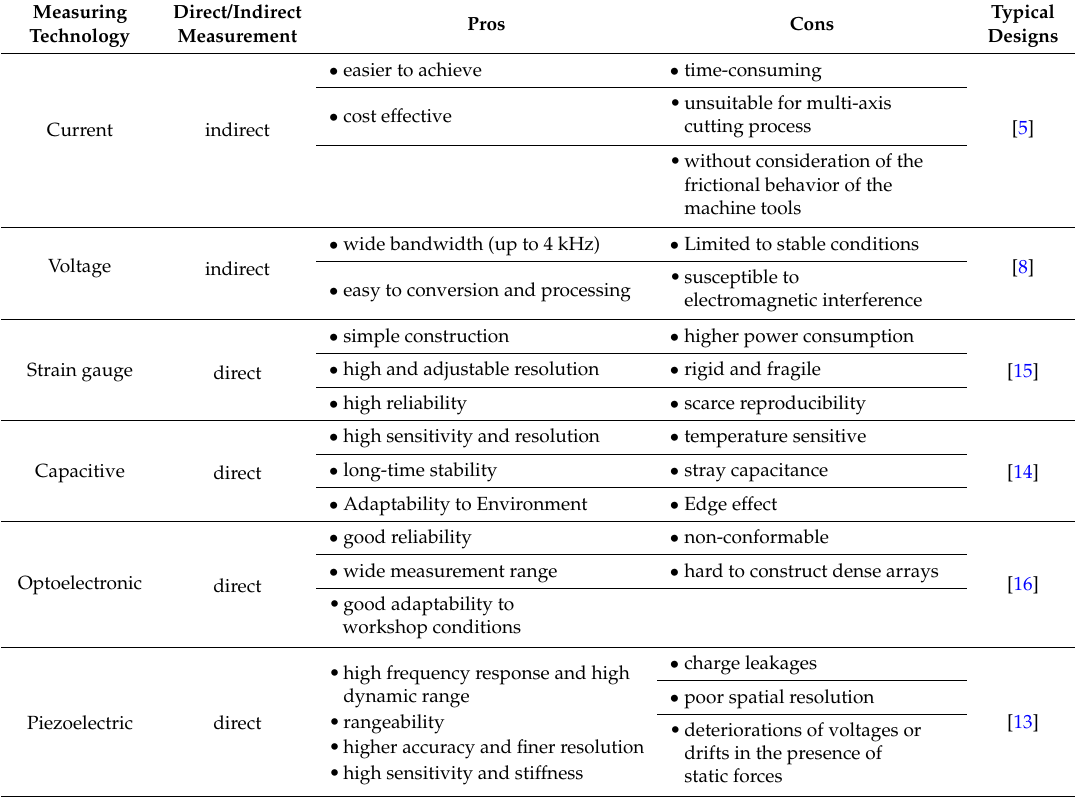
Table 1. Intrinsic transduction techniques for cutting force